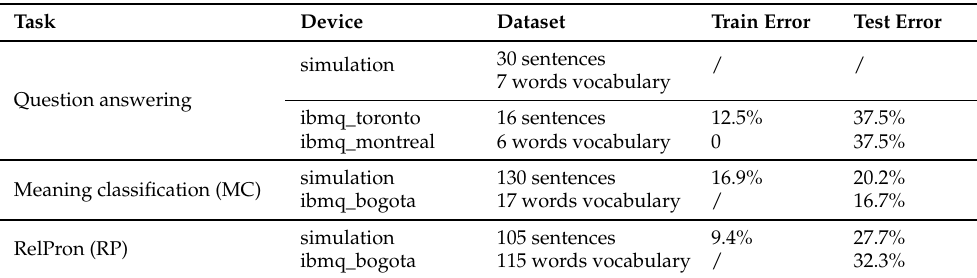
Table 3. Comparison of quantum experiments running on NISQ hardware. Note that not all details are given in the description of the experiments performed. Concering NISQ devices, all machines used have 5 qubits available and a quantum volume equal to